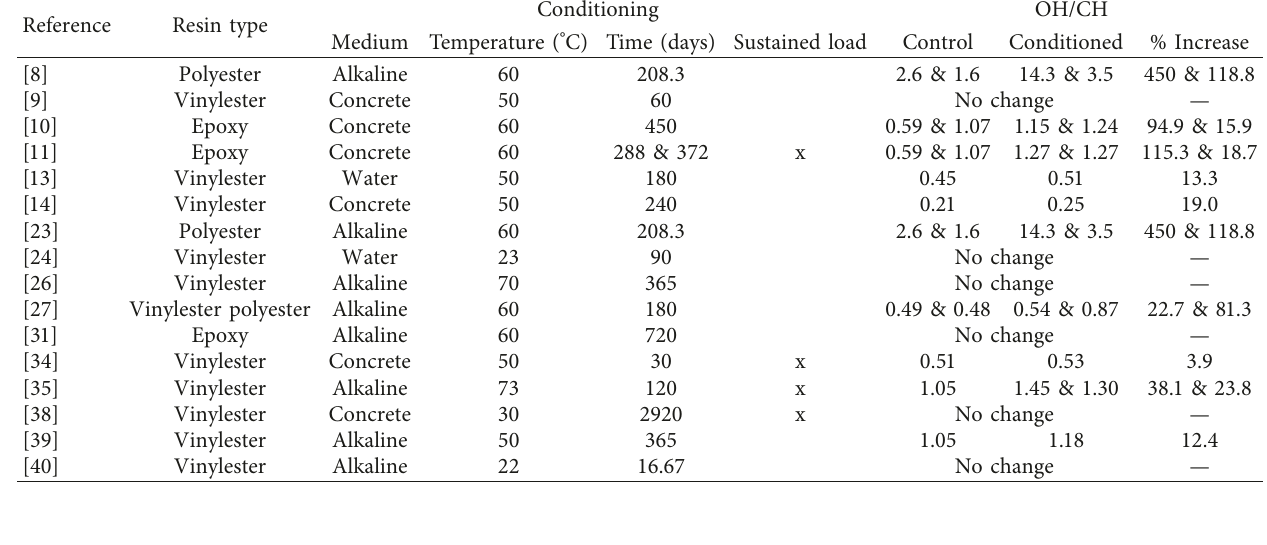
Table 10: Results of OH/CH ratios in control and conditioned GFRP reinforcing bars. Reference